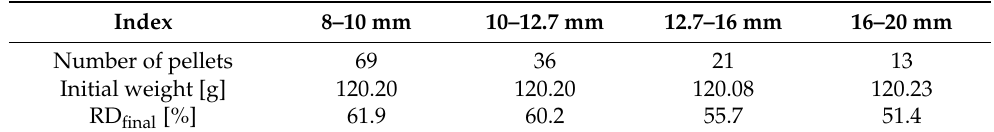
Table 2. Numerical values of the reducibility tests.